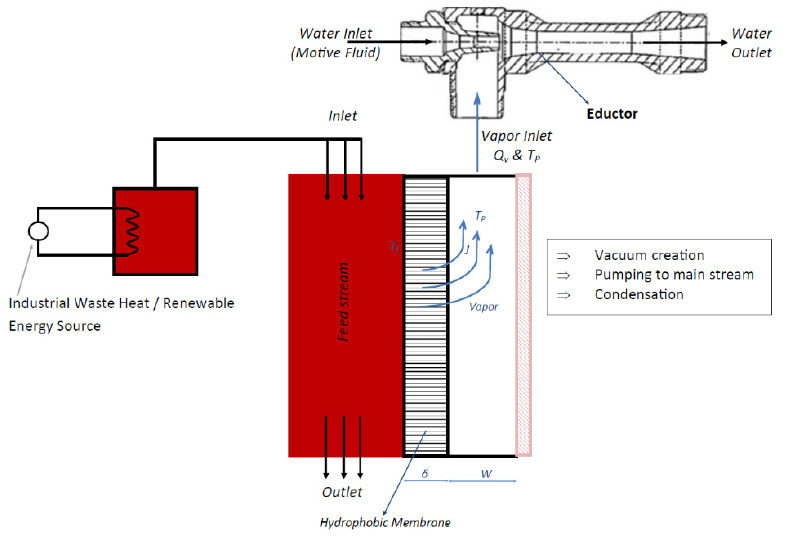
Figure 33. Proposed layout of ejector-based vacuum membrane distillation desalination process.